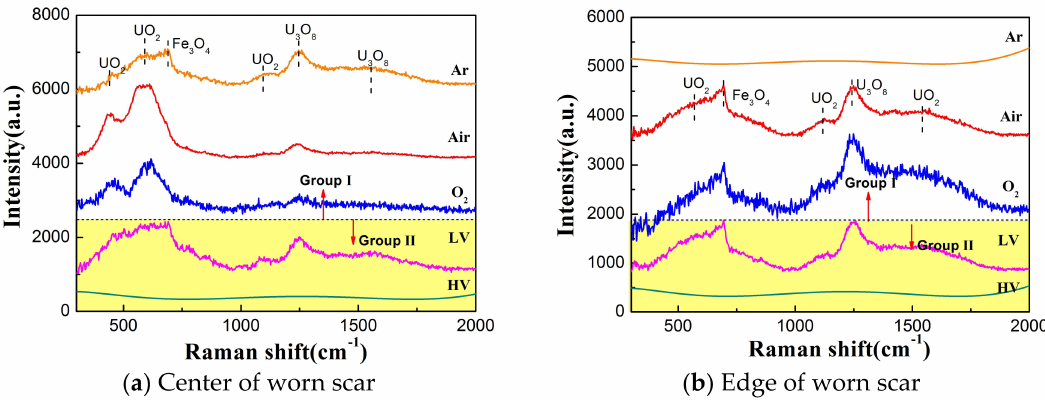
Figure 8. The Raman spectrum of the wear surface under different atmosphere and vacuum